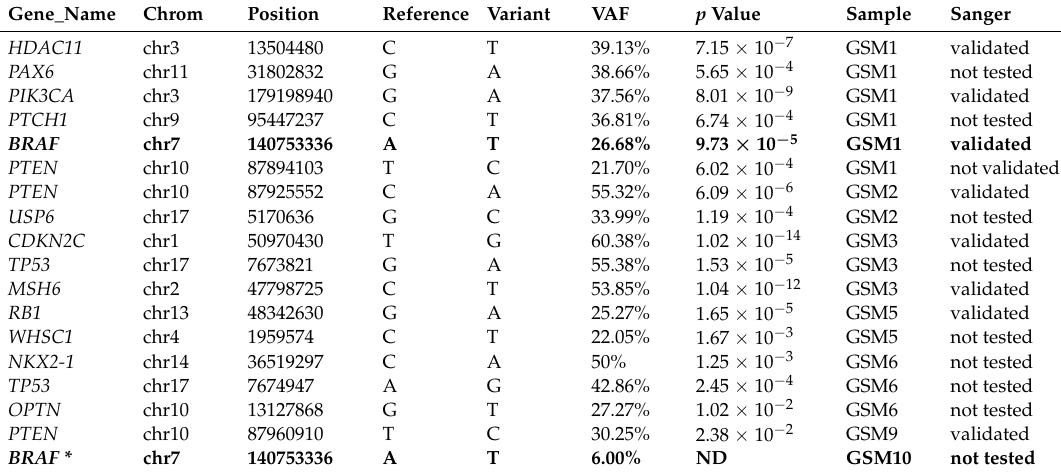
Table 1. Somatic mutations in gliosarcomas. Table is sorted by sample name and secondly by VAF (variant allele frequency) of mutation in a tumor sample. p value is a somatic status p -value from Varscan2 analysis. In bold—the only detected recurrent position of mutation in samples GSM1 and GSM10 in BRAF (V600E). Mutations in a table are all missense/nonsense mutations called as non-tolerated/non-benign by SIFT/Polyphen2 algorithms and are found with minimal penetration of a mutated allele >20% except one BRAF mutation marked as *. Selected variants have been additionally validated by Sanger sequencing, one variant failed to be validated by Sanger sequencing, most likely due to the fact, that validation had to be performed from different tissue specimen isolation. ND—it was not detected in primary Varscan2 analysis but it was found in secondary manual